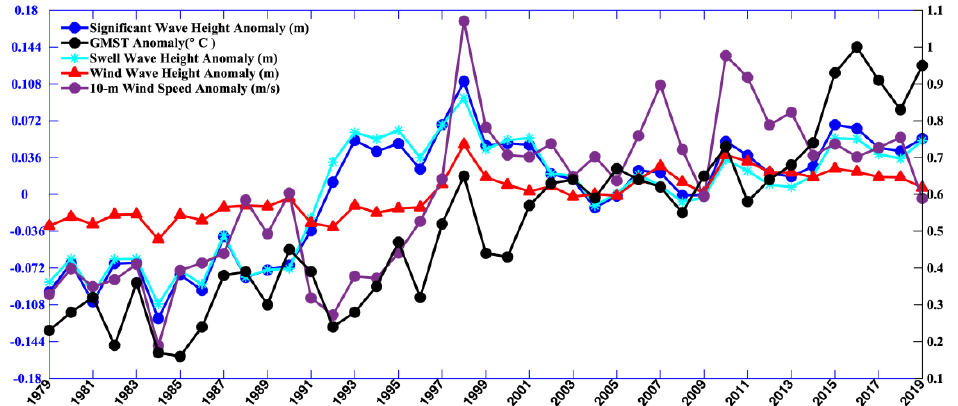
Figure 6 . Time series of annual anomalies of global mean SWH (solid blue line; units: m), global mean surface wind speed (solid purple line; units: m/s), global mean swell wave height (solid cyan line; units: m), and global mean wind wave height (solid red line; units: m) from the ERA5 reanalysis data. The black line is the global mean surface temperature anomalies with respect to the years 1981 – 2010. The wave height anomaly quantities are represented on the left axis and the wind speed anomalies are represented on the right axis.